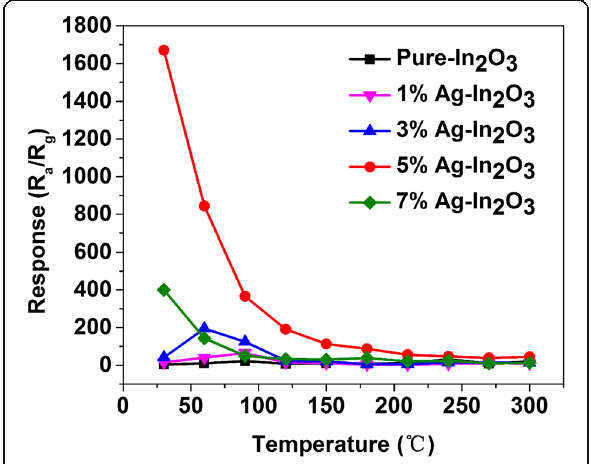
Fig. 7 Responses of pure In 2 O 3 , 1%Ag-In 2 O 3 , 3%Ag-In 2 O 3 , 5%Ag- In 2 O 3 , and 7%Ag-In 2 O 3 gas sensors to 5 ppm gaseous formaldehyde in the operating temperature range from 30 to 300